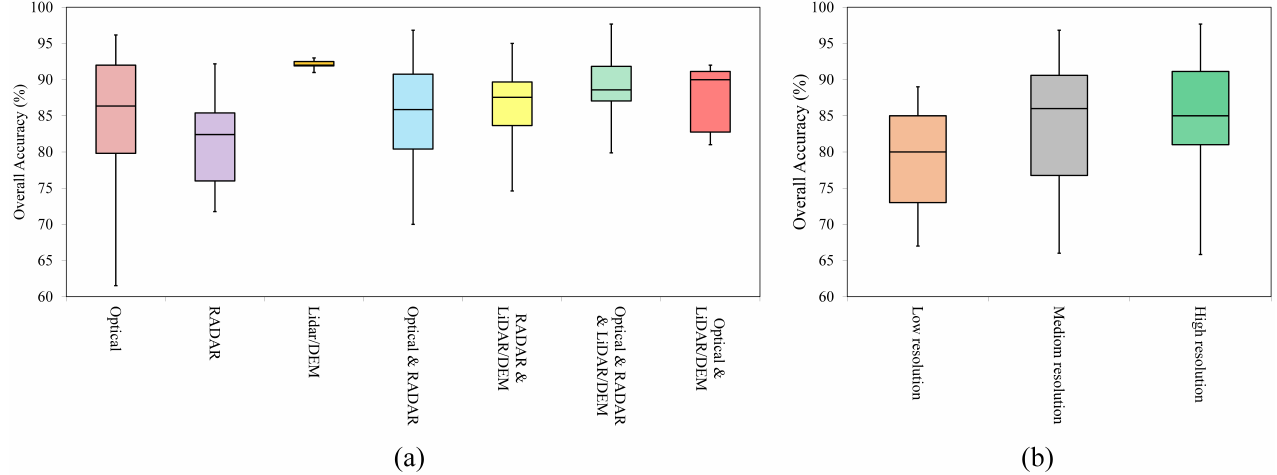
Figure 15. The overall accuracies reported in RS-based wetland classification studies in Canada ( a ) based on the different data types employed, and ( b ) based on the spatial resolution of the